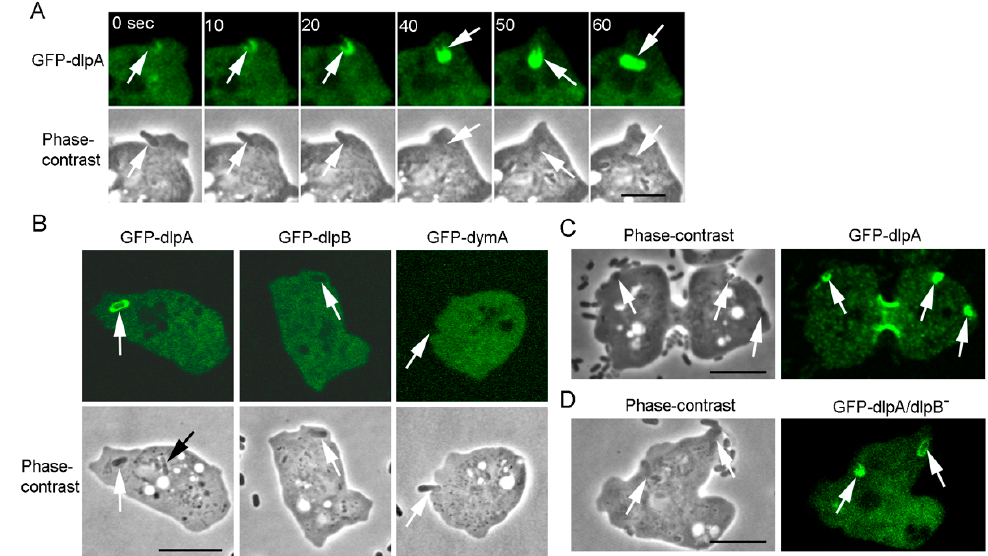
Figure 7. DlpA localizes at the phagocytic cups independently of dlpB. ( A ) A typical sequence of phagocytosis of a cell expressing GFP-dlpA. GFP-dlpA first appeared around the bacterium, and then encircled the endosome after it was engulfed (arrows). ( B ) Bacteria were added to each null mutant cell line expressing GFP-dlpA, GFP-dlpB, and GFP-dymA, independently. DlpB and dymA did not accumulate to the phagocytic cups in contrast to dlpA (white arrows). About 1 min after the bacteria were internalized, dlpA disappeared from the endosome (black arrow). ( C ) GFP-dlpA also localized at the phagocytic cups in dividing cells (arrows). Incidentally, GFP-dlpB did not localize at the phagocytic cups in dividing cells (data not shown). ( D ) Typical phase contrast and fluorescence images of a dlpB - cell expressing GFP-dlpA. GFP-dlpA localized at the phagocytic cups independently of dlpB (arrows). Bars, 10 µm.